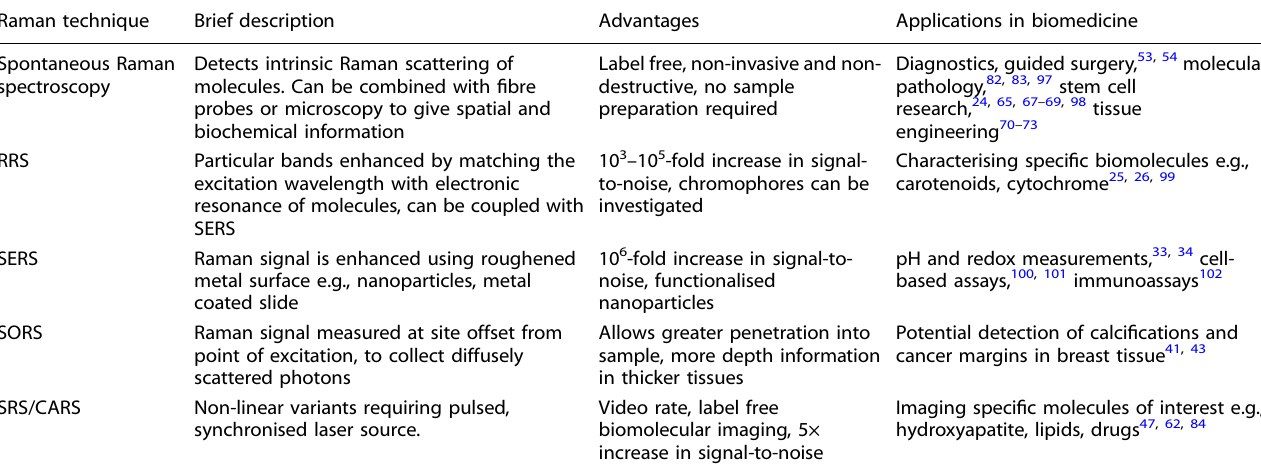
Table 1. Summary of Raman spectroscopy